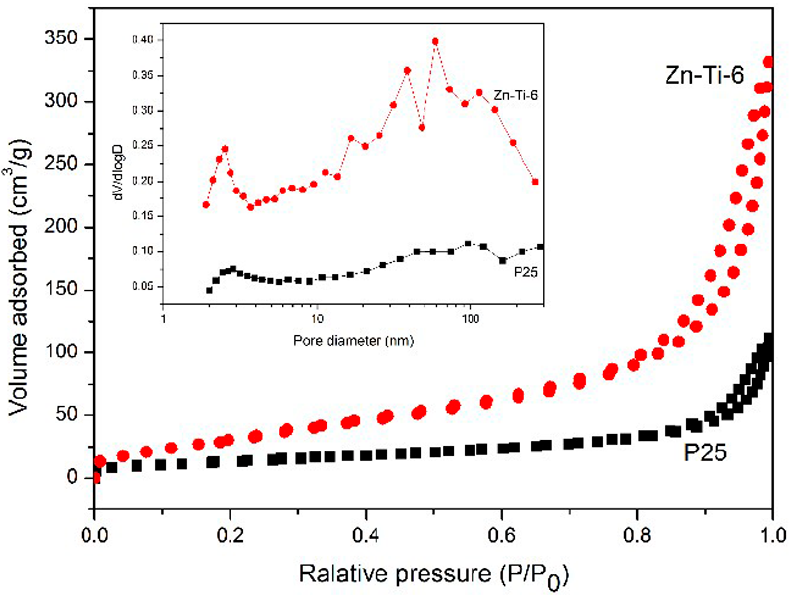
Figure 4. Typical N 2 adsorption–desorption isotherms and their corresponding pore size distribution curves (inset) of P25 and Zn-Ti-6.